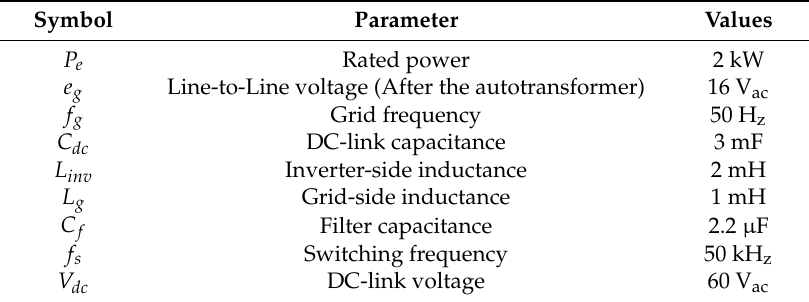
Table 2. Parameter specifications in experiment.